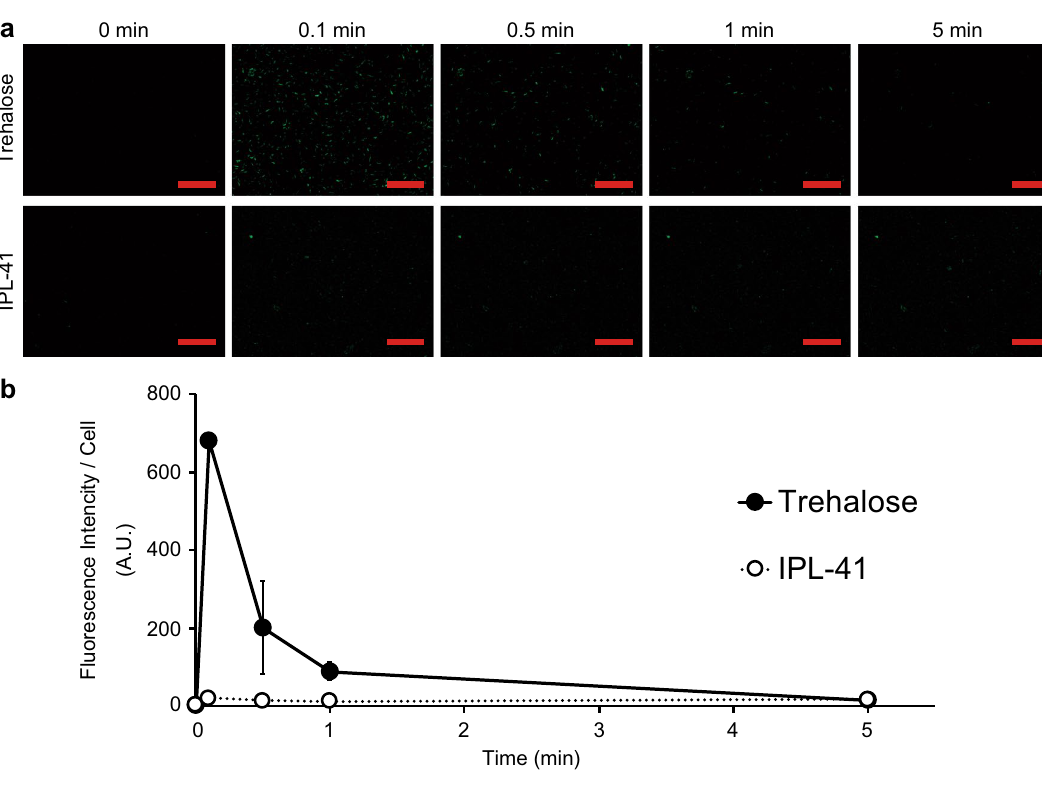
Figure 3. Intracellular Ca 2+ mobilization in GCaMP3-KI cells during trehalose treatment. ( a ) Trehalose treatment induces a transient increase in GCaMP3 fluorescence in cells. ( b ) Quantitative data are shown. Scale bars, 100 µm. Values are expressed as mean ± SD; n = 3 in each